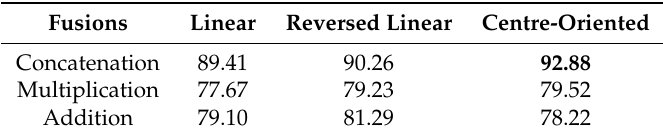
Table 14. Performance of the proposed method for different weight aspects for the FWMDMMs fused with spatial information (RGB and depth). Results are for the MSR daily activity 3D dataset.